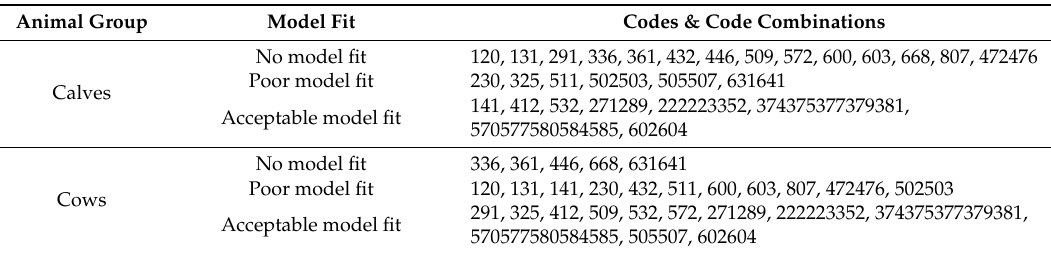
Table 6. Selected codes resulting in lack of estimates due to no model fit (too few positive observations), poor model fit and acceptable model fit for data on